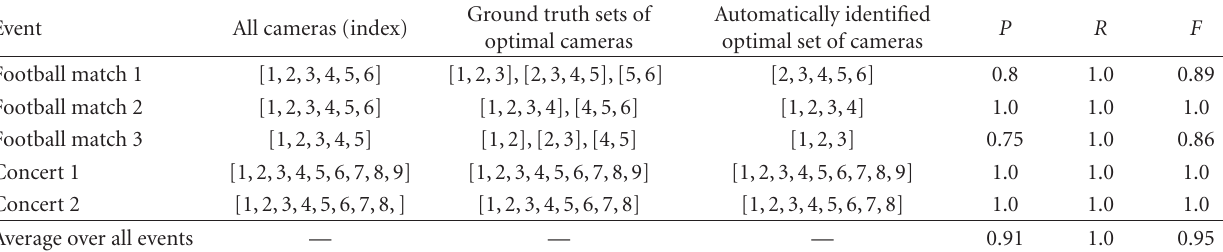
Table 6: Experimental results on identifying the optimal cameras. P stands for Precision , R for Recall, and F for F-measure . Event